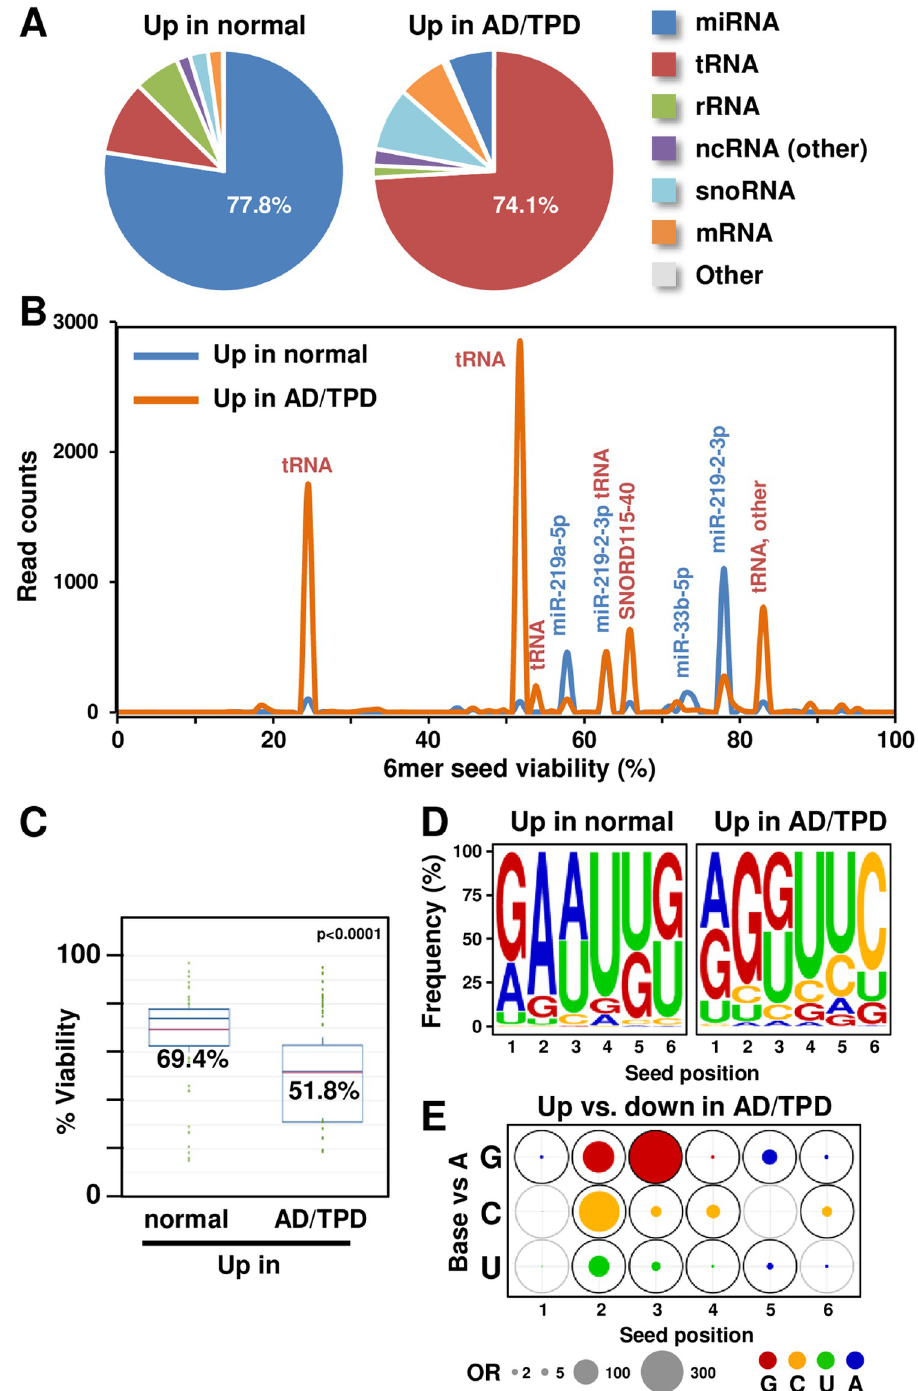
Fig 3. sRNAs enriched in AD brains contain more toxic seeds than in control brains. (A) Pie charts showing composition of sRNAs differentially expressed in normal and AD patient brains. (B) Seed Tox plots of sRNAs differentially expressed in brain samples in A. When a peak is labeled with multiple miRNAs (blue), the most abundant one is listed first. RNAs are only labeled if they account for 1000 reads or more. miRNAs are labeled in blue, other sRNAs in red. (C) Average predicted 6mer seed toxicity of all differentially regulated sRNAs in brain samples in A. p- value was calculated using a Wilcoxon rank test. (D) Seed composition of all RISC-bound differentially regulated sRNAs in brain samples in A. (E) Positional changes in the 6mer seed composition in reads significantly up- and